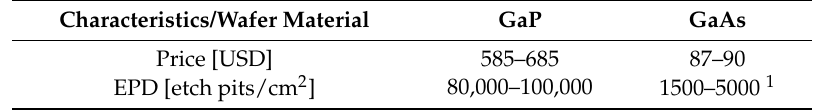
Table 2. A comparison of price and quality (EPD/cm 2 ) of commercial 2-inch GaP and GaAs wafers. Characteristics/Wafer Material